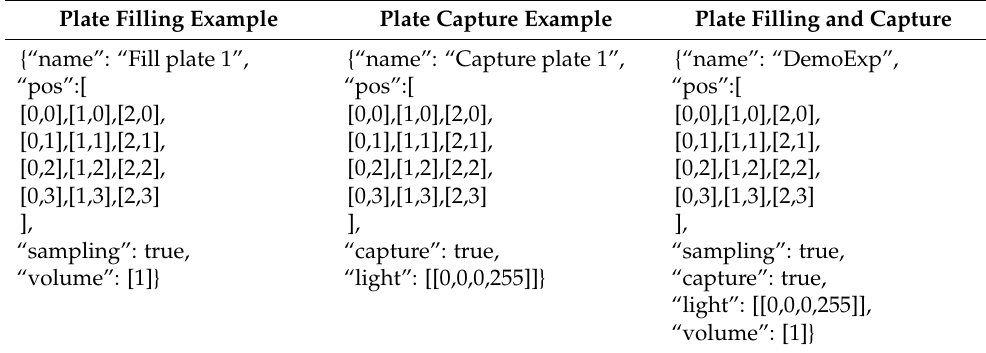
Table 2. Example of JSON scripts that allows the filling of a plate, taking pictures of a pre-filled plate, or performing these two tasks at once. Plate Filling Example Plate Capture Example Plate Filling and